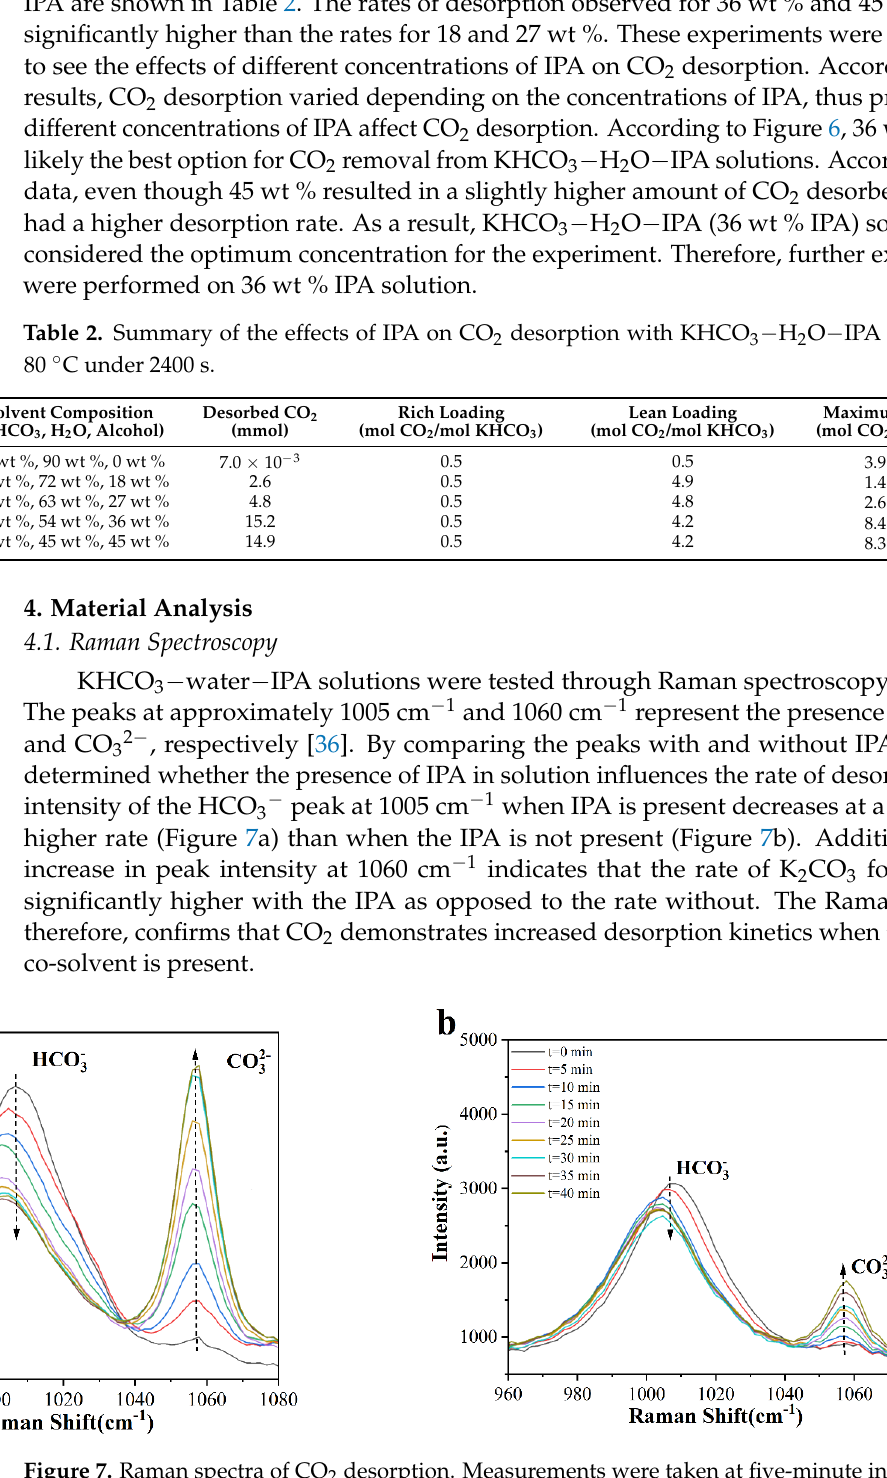
Table 2. Summary of the effects of IPA on CO 2 desorption with KHCO 3 − H 2 O − IPA solutions at 80 °C under 2400 s.